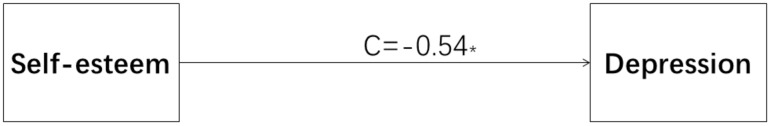
The relationship between self-esteem and depression among transgender women sex workers. ∗p < 0.05.